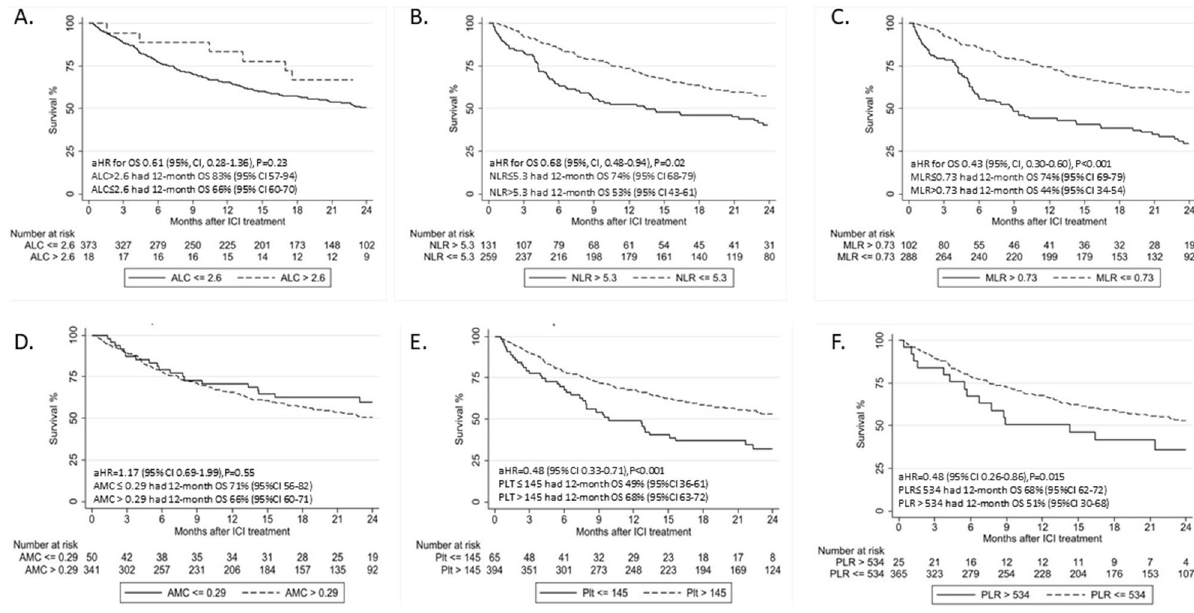
Figure 1. Overall survival (OS) by laboratory cutpoints. Kaplan Meier estimates of OS in patients with ( A ) absolute lymphocyte count > and ≤ 2.6k/ul, ( B ) neutrophil to lymphocyte ratio > and ≤ 5.3 ( C ) monocyte to lymphocyte ratio > and ≤ 0.73, ( D ) absolute monocyte count > and ≤ 0.29 k/ul, ( E ) platelent count > and ≤ 145 k/ul and ( F ) platelet to lymphocyte count > and ≤ 534. aHR adjusted hazard ratio, ICI immune checkpoint inhibitors, ALC absolute lymphocyte count, NLR neutrophil to lymphocyte ratio, MLR monocyte to lymphocyte ratio, AMC absolute monocyte count, Plt platelet count, PLR platelet to lymphocyte count, OS overall survival, CI confidence